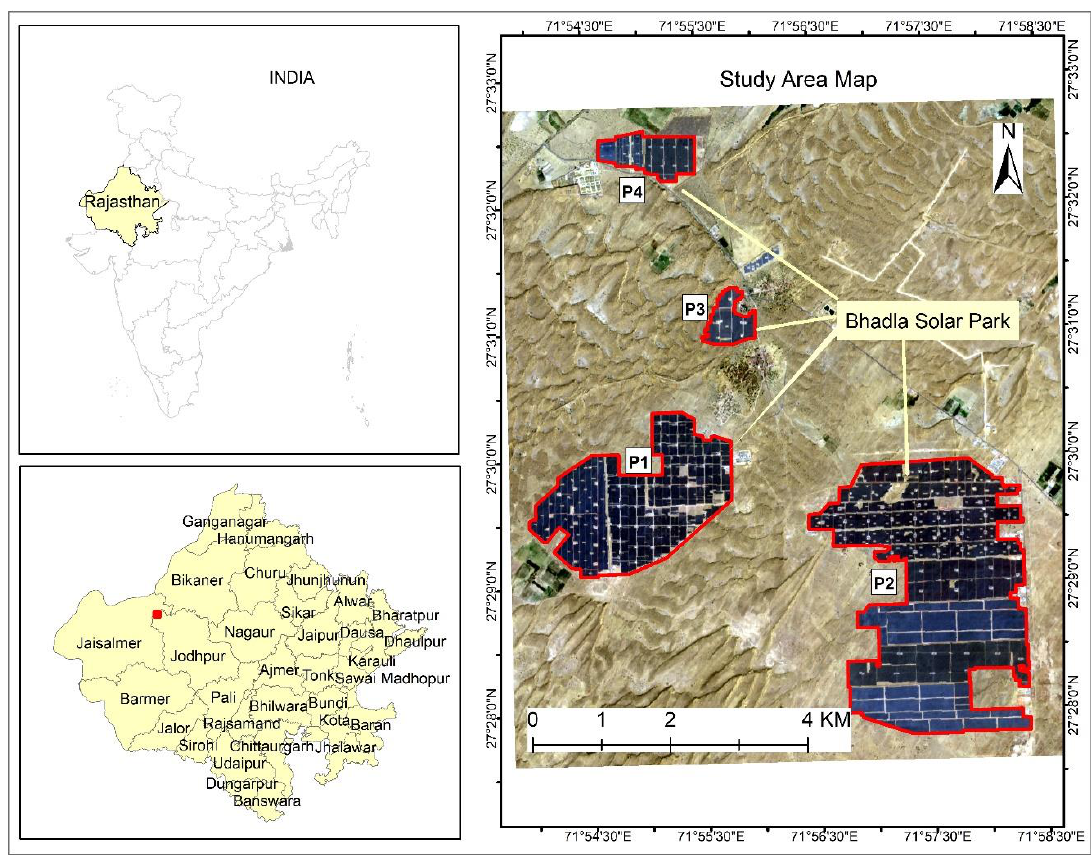
Figure 2. Location of Bhadla solar park in the state of Rajasthan in India and location of four photovoltaic (PV) parks (P1, P2, P3 and P4). Red square in lower left panel indicates the location of the study area in Rajasthan State.